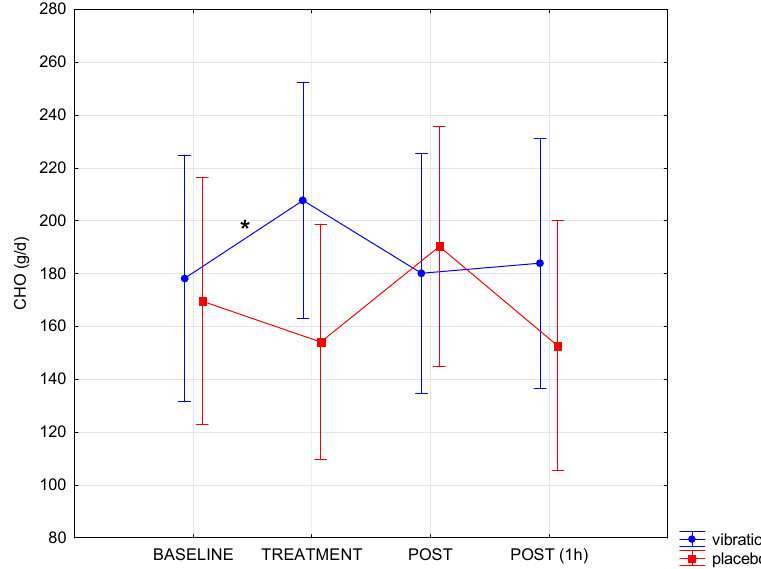
Figure 3. Changes in resting metabolic rate (RMR) pre- (baseline), during (treatment) and post-vi- bration (* significant change compared to baseline in WBV group). The data are presented as mean and 95% CI.